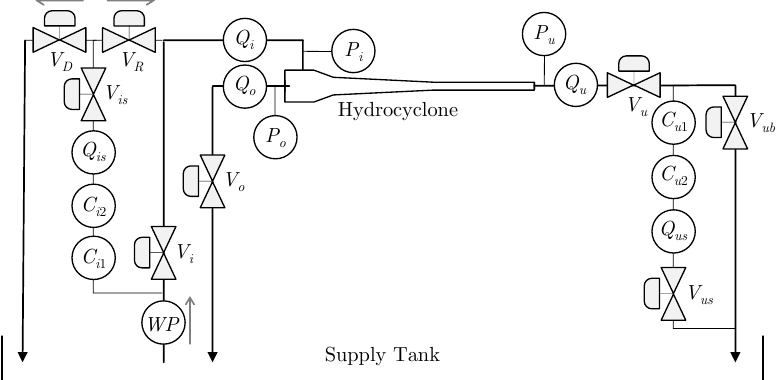
Figure 13. Pipeline and instrumentation diagram of the hydrocyclone subsystem of the pilot